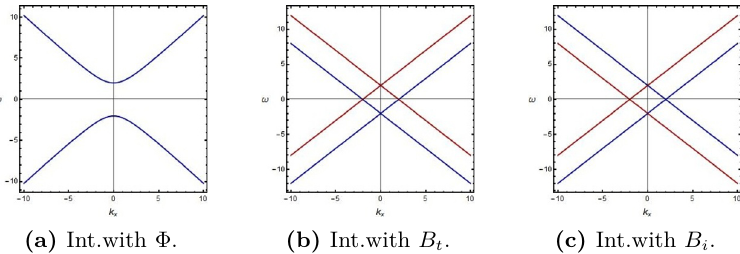
Figure 5. SF for two flavors. (a) scalar interaction generates a gap. (b) B t shift the spectrum along ω direction. The configuration has rotational symmetry in k x , k y space. (c) B i shift the spectral cone along k i direction. Different flavor shifts in opposite